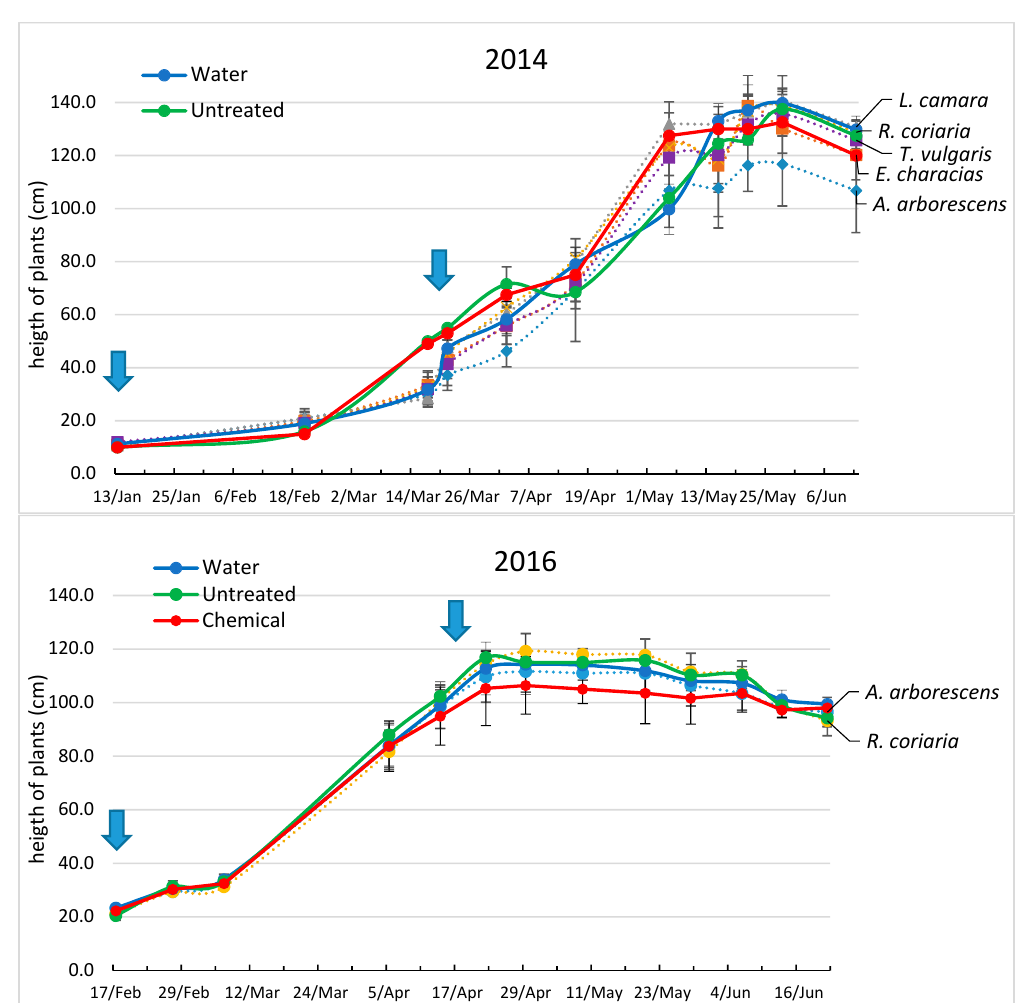
Figure 2. Height of wheat plants measured throughout the trial periods in 2014 and 2016. For each treatment and survey date, each point is the average of five measurements ± standard deviation . Solid lines refer to the controls (water, blue; untreated, green; chemical, red); dotted lines refer to the treatments with water extracts (labels at the last point of the line). In each panel, the arrows indicate the date of the two treatments.